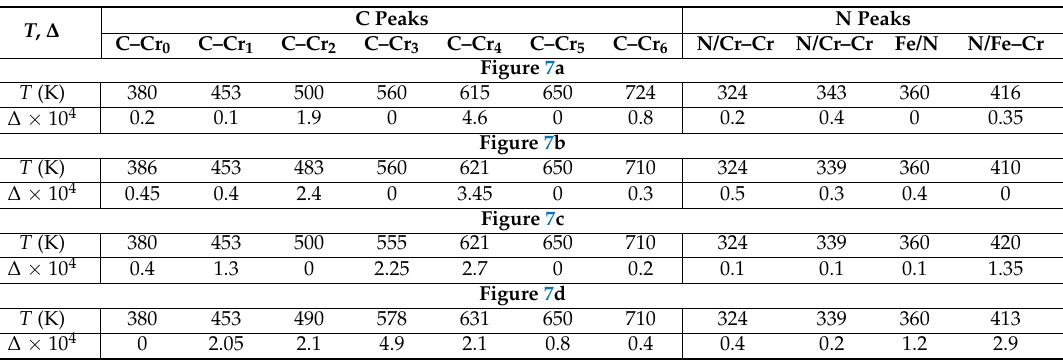
Table 4. Temperatures T and relaxation strengths ∆ of the Q − 1 peaks used to fit MS experimental data displayed in Figure 7, quenched at 3600 (Figure 7a,b) and 150 K/min (Figure 7c,d), and treated at 973 K for 3.6 × 10 4 s (Figure 7a,c) and 7.2 × 10 4 s (Figure